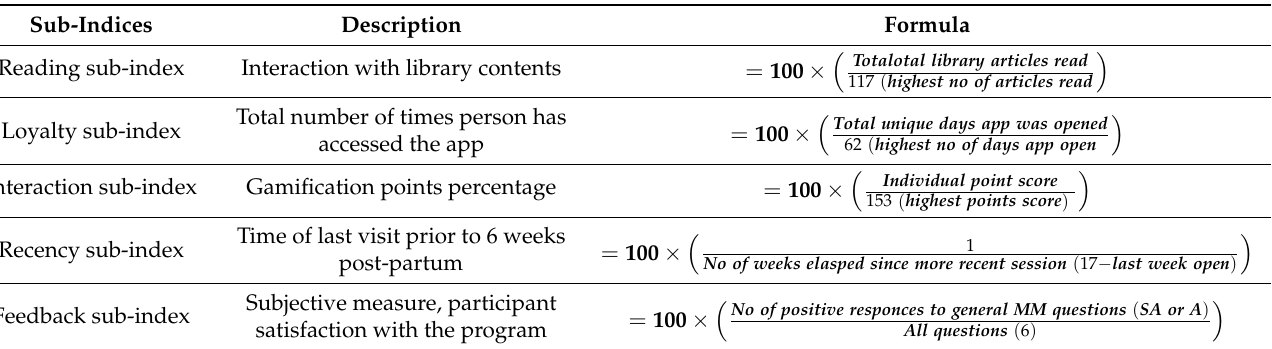
Table 1. Milk Man engagement